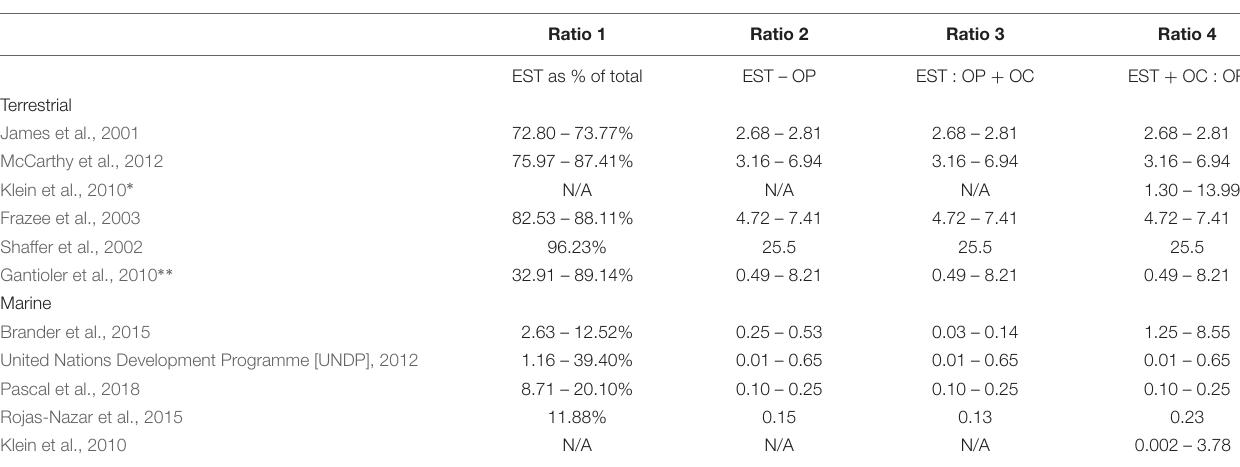
FIGURE 1 | Graphic demonstrating the range of Ratio 2 values (Establishment to Operational costs) calculated for five TPA and four MPA studies from Table 4 . Bars indicate the boundaries of minimum and maximum ratio values for individual studies. Circles denote ratios for studies that only returned one value. The range of values are written next to their corresponding bars and circles. TABLE 4 | Cost ratios per each eligible